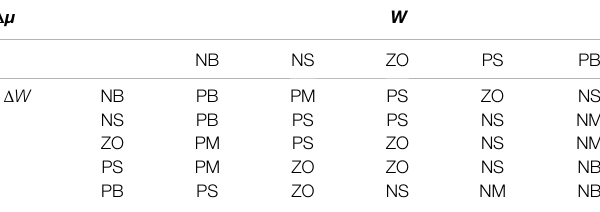
TABLE 2 | Fuzzy control rule